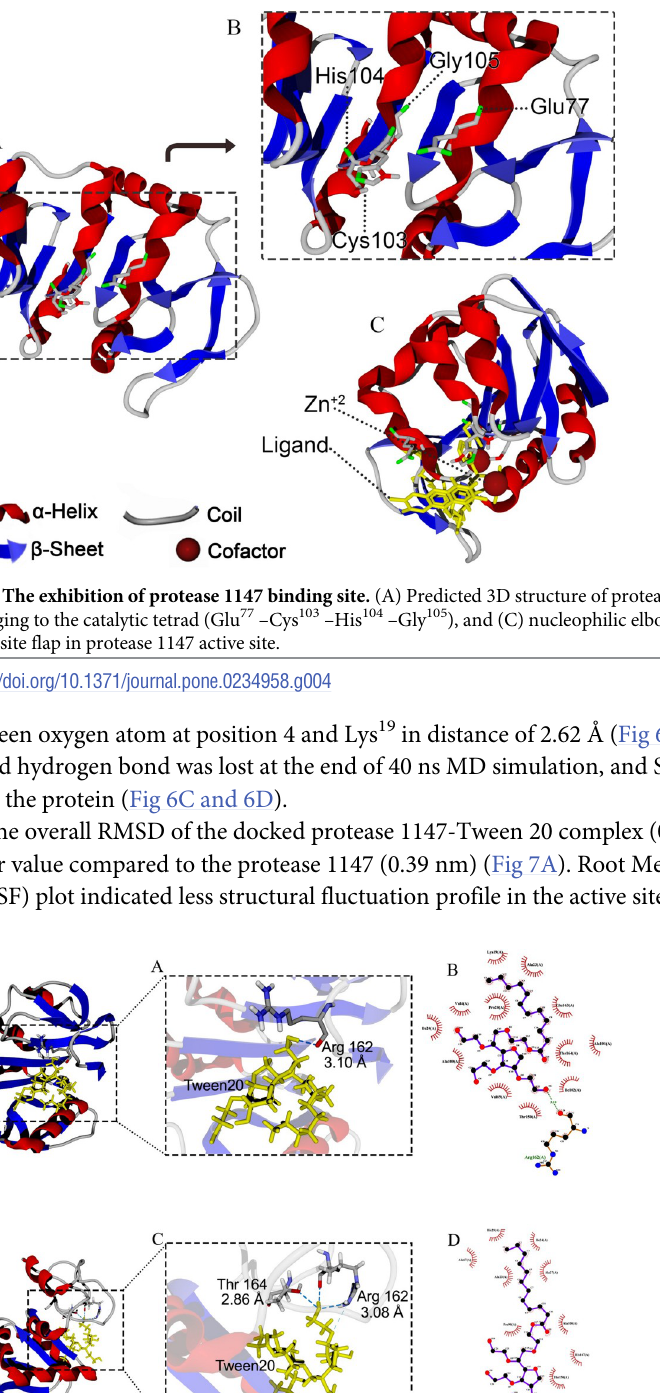
Fig 5. Docking of protease 1147 and Tween ligand. (A) Docked protease 1147-Tween 20 complex (before MD simulation), and (B) its 2-D display indicated an interaction between Arg 162 of protease 1147 with oxygen atom at position 6 of Tween 20. (C) Docked protease 1147-Tween 20 complex (after MD simulation), and (D) its 2-D display indicated two interactions between Arg 162 and Thr 164 of protease 1147 with Tween20.